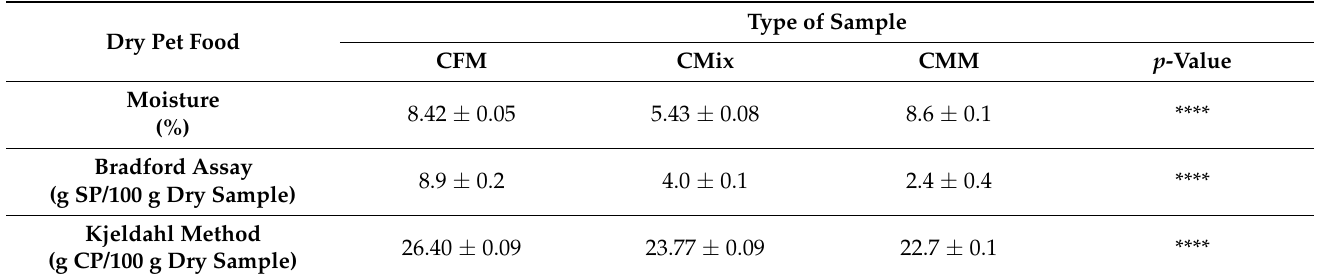
Table 1. Moisture, soluble protein (SP) content determined by the Bradford assay, and crude protein (CP) content determined by the Kjeldahl method in CFM, CMix, and CMM formulations. Data are reported as mean ± SEM, n = 12. **** p <